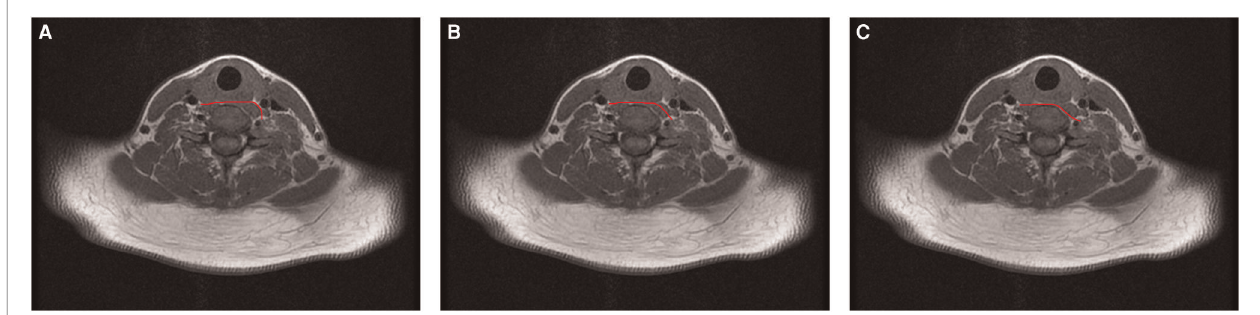
FIGURE 2 | Prespinal routes of CC7 transfer surgery on T1-weighted images (T1WI): ( A ) anterior route, ( B ) middle route, ( C ) posterior route.